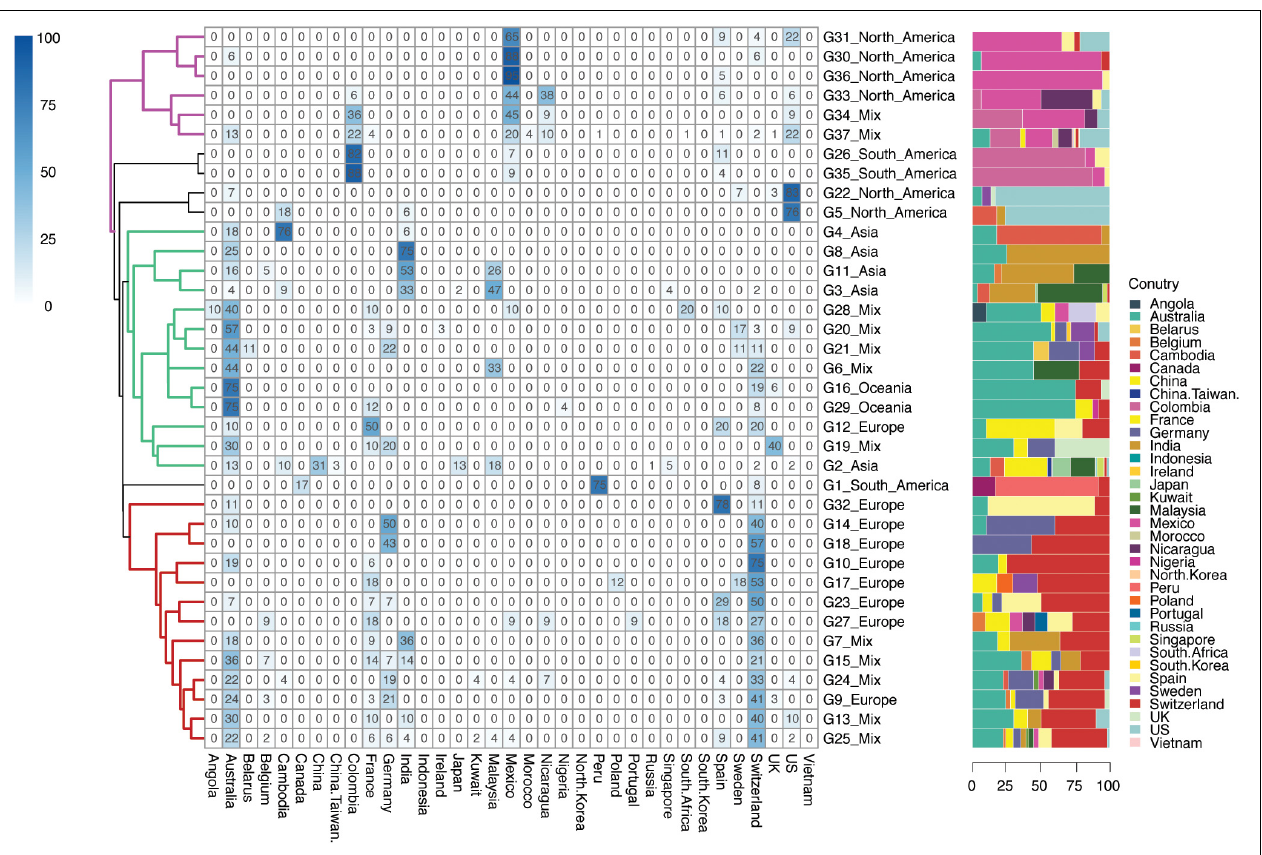
FIGURE 3 | Geographical clustering of H. pylori country subclades. The number in each cube represents the percentage of unique isolates sourced from each of the countries in that continent group. A total number of 216 country-level groups were defined. The deeper the color, the higher the percentage of the isolates sourced from that country in continent-level groups. Background information on isolates is provided in Supplementary Table 1